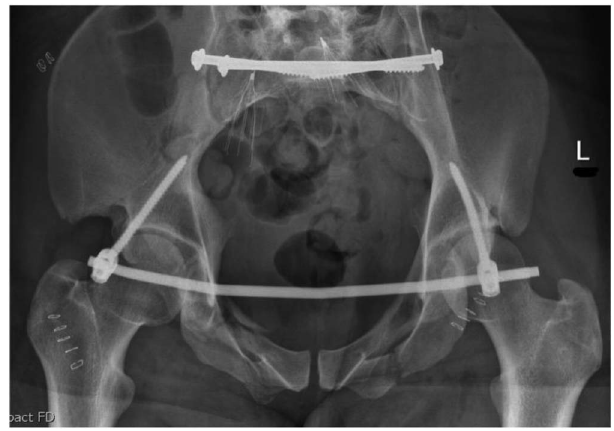
Figure 8. Day 1 after fi xation. Bilateral sacroiliac joint screws with INFIX. Inlet image. Figure 10. After union and removal of INFIX. Mild right-sided heterotopic ossi fi cation noted. AP